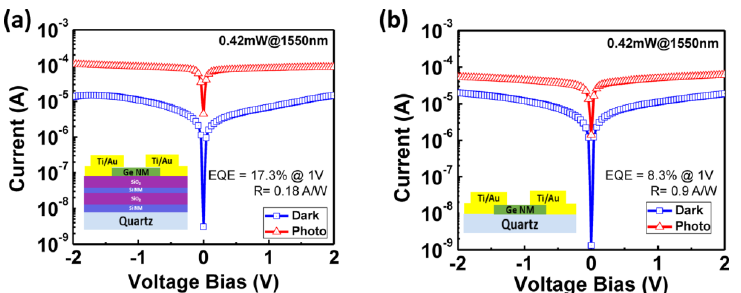
photodetector on quartz substrate (reprinted from